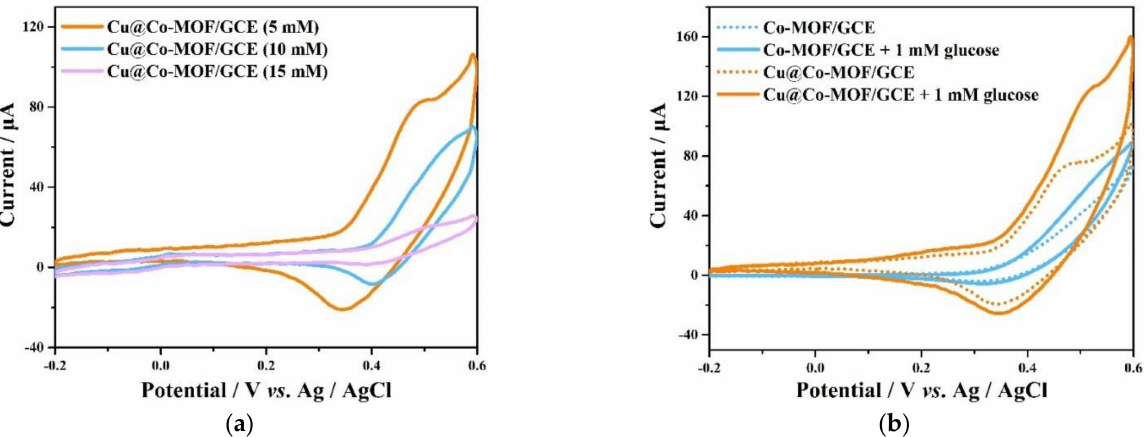
Figure 5. ( a ) CV curves of Cu@Co–MOF/GCE with Cu 2+ concentration within 5–15 mM; ( b ) CV curves of Cu@Co–MOF/GCE and Co–MOF/GCE in 0.01 M NaOH with (solid line) or without (dash line) 1 mM Glu